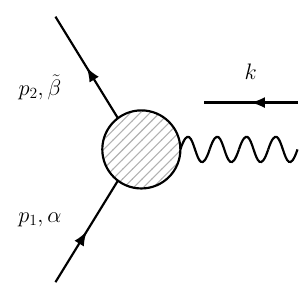
Figure 2 . Tree-level three-point scattering